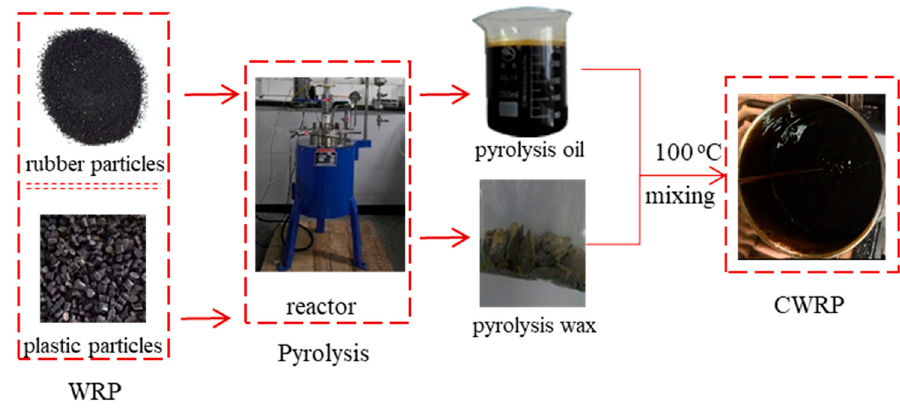
Figure 2. Production program of CWRP .